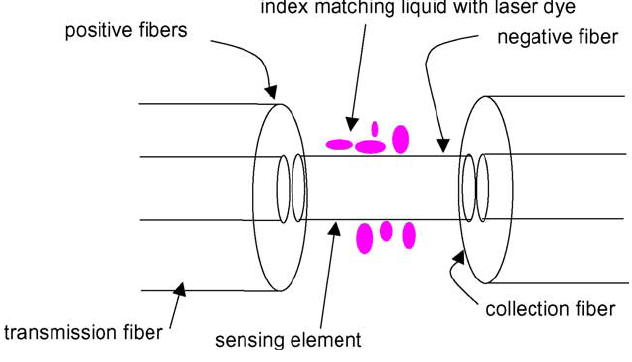
Figure 2. Schematic of fiber-based evanescent wave fluorescence sensor [9], reproduced by the permission of